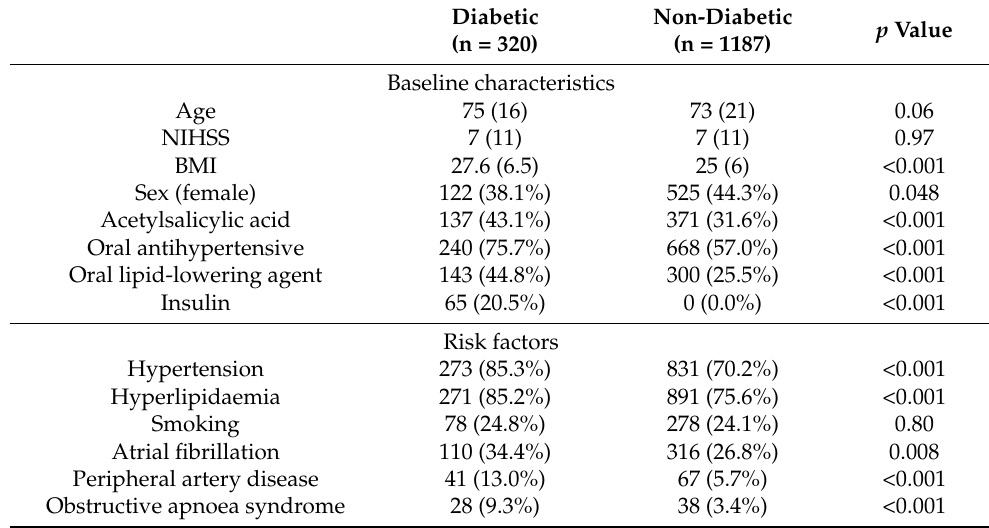
Table 1. Univariable analysis (only selected variables shown, see also Supplementary Table